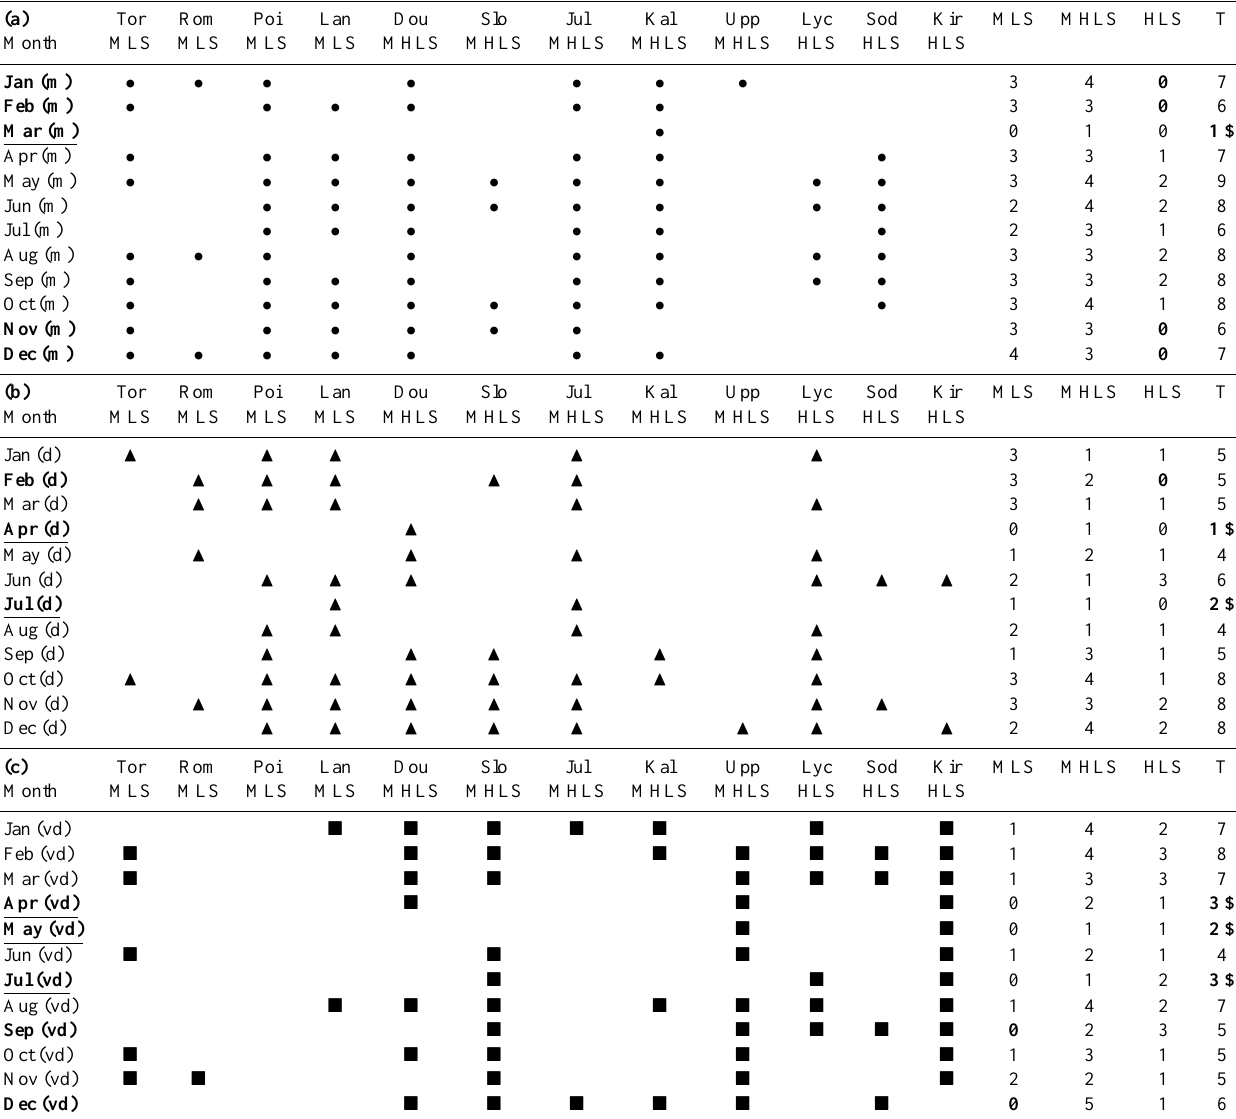
Table 6. Use of RM_M3000F2 , RM_M3000F2_BD , and IRI_RM_M3000F2_BD under (a) moderate, (b) disturbed, and (c) very disturbed geomagnetic conditions respectively. The months for which M3000F2 predictions are provided over a more restricted area because of the lack of MLS or HLS, and the months where the model is not able to assure a coverage of the area under consideration because of the lack of an adequate number of sites operating at the same time, are marked in bold and underlined bold